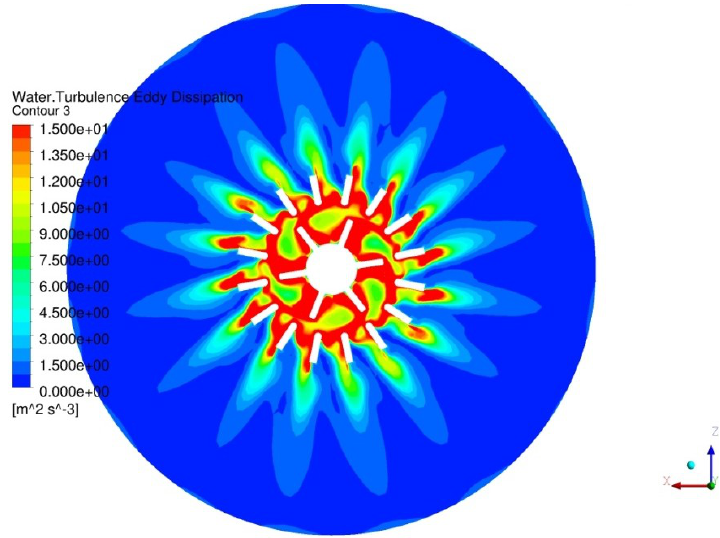
Figure 11. Turbulent kinetic energy dissipation rate in a horizontal plane passing through the